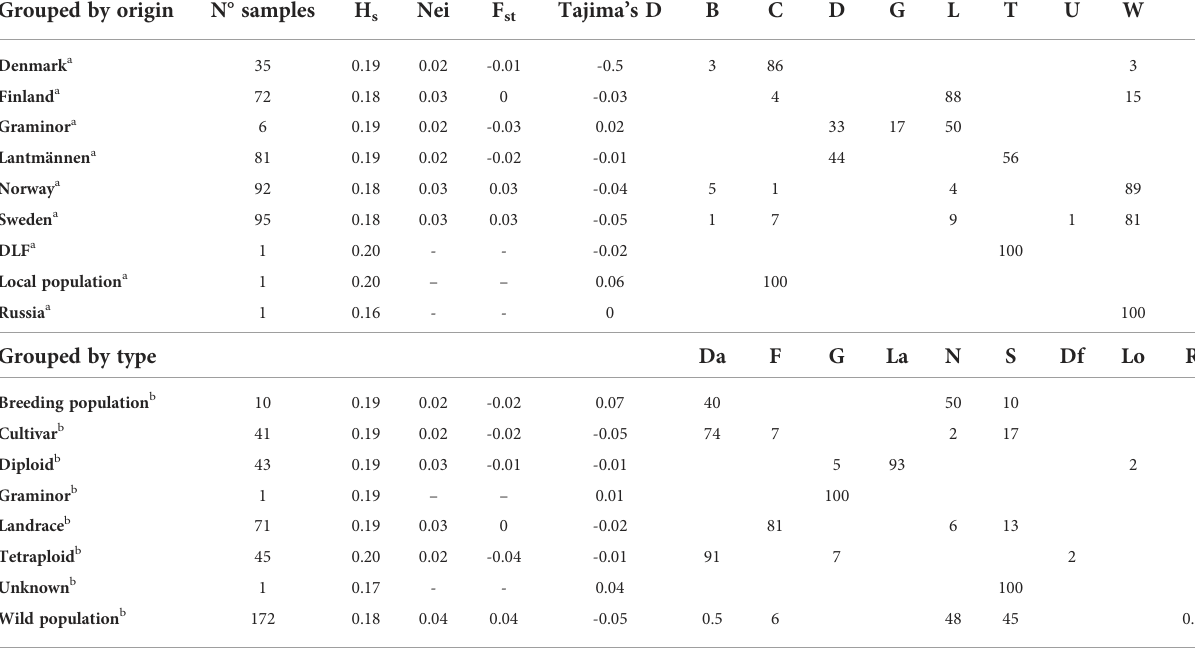
TABLE 1 The fi rst column indicates the number of samples in different groups of red clover populations grouped according to their origin or population type. Grouped by